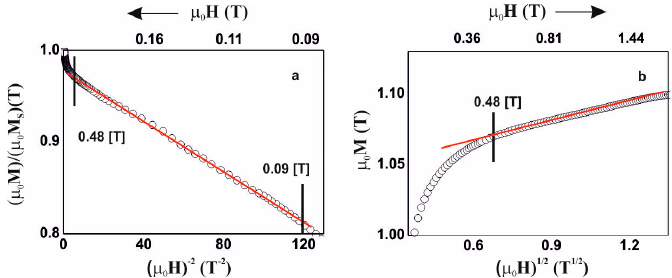
Figure 6. Magnetisation for the alloy Fe 36 Co 36 Y 8 B 20, as a function of: ( a ) (µ 0 H) − 1 , ( b ) (µ 0 H) ×2 , ( c ) (µ 0 H) 1/2 .